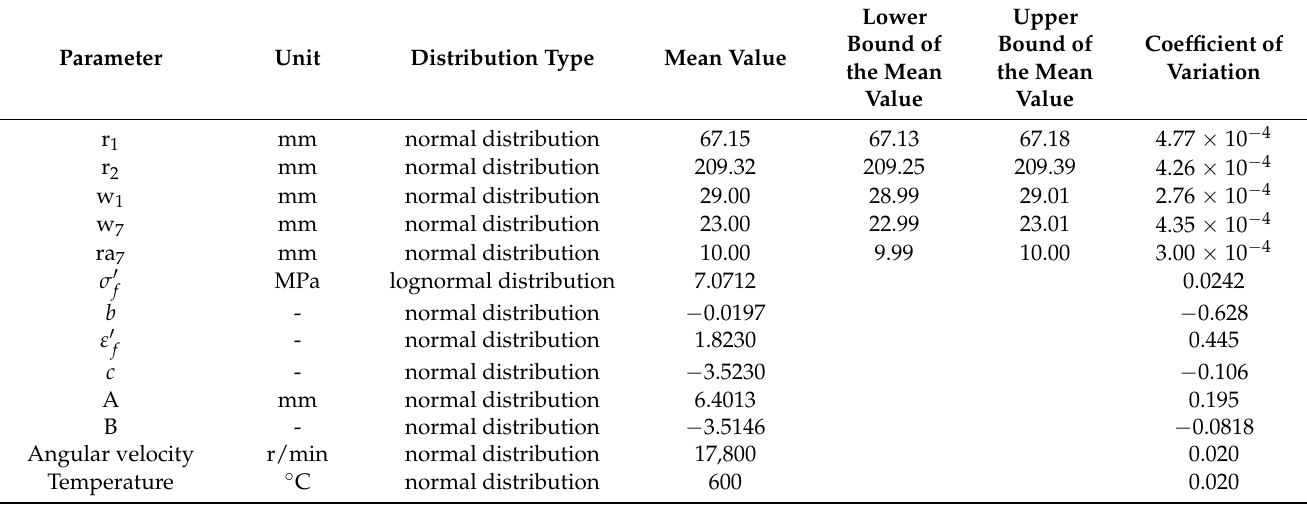
Table 4. Uncertainty of model parameters.